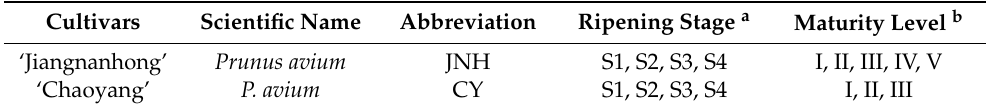
Table 1. The cultivars used in the present study.